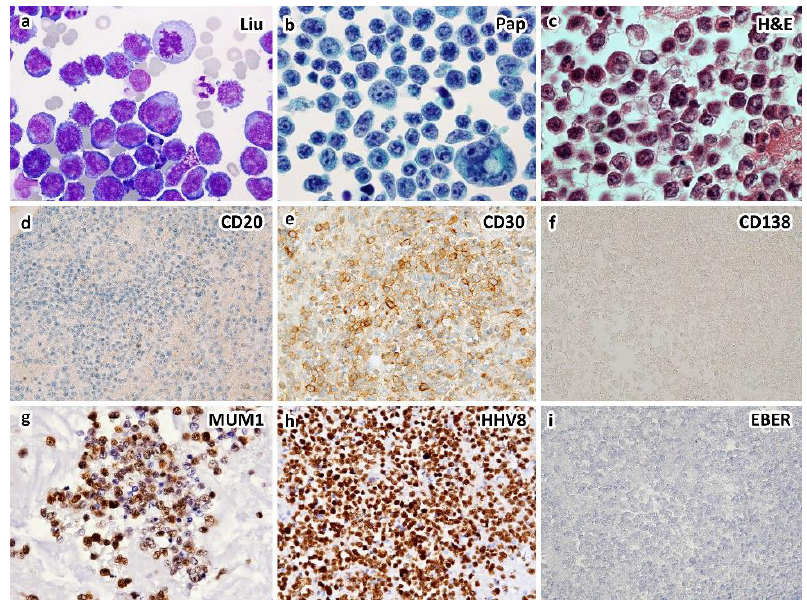
Figure 1 . A case of HIV-unrelated, HHV8-positive primary effusion lymphoma occurring in a 72-year-old immunocompetent man who presented with bilateral pleural effusions. Cytological smears show large, atypical lymphocytes with centroblastic, immunoblastic, plasmablastic, and anaplastic morphology by Liu ( a ) and Papanicolaou ( b ) stains. Cell block section shows large, atypical lymphocytes with nucleoli and occasional binucleation (( c ), H&E stain). Immunohistochemically, the atypical lymphocytes express CD30 ( e ), CD45, HHV8-LANA1 ( h ) and IRF4/MUM1 ( g ), but not CD3, CD19, CD20 ( d ), CD79a, CD138 ( f ), PAX5 or ALK. Ki-67 proliferation index is up to 70%. EBER in situ hybridization is negative ( i ). Primary effusion lymphoma is diagnosed. Serum HIV test is negative. The patient does not have underlying immunodeficiency (( a – c ), ×1000; ( d – i ), ×400 magnification).